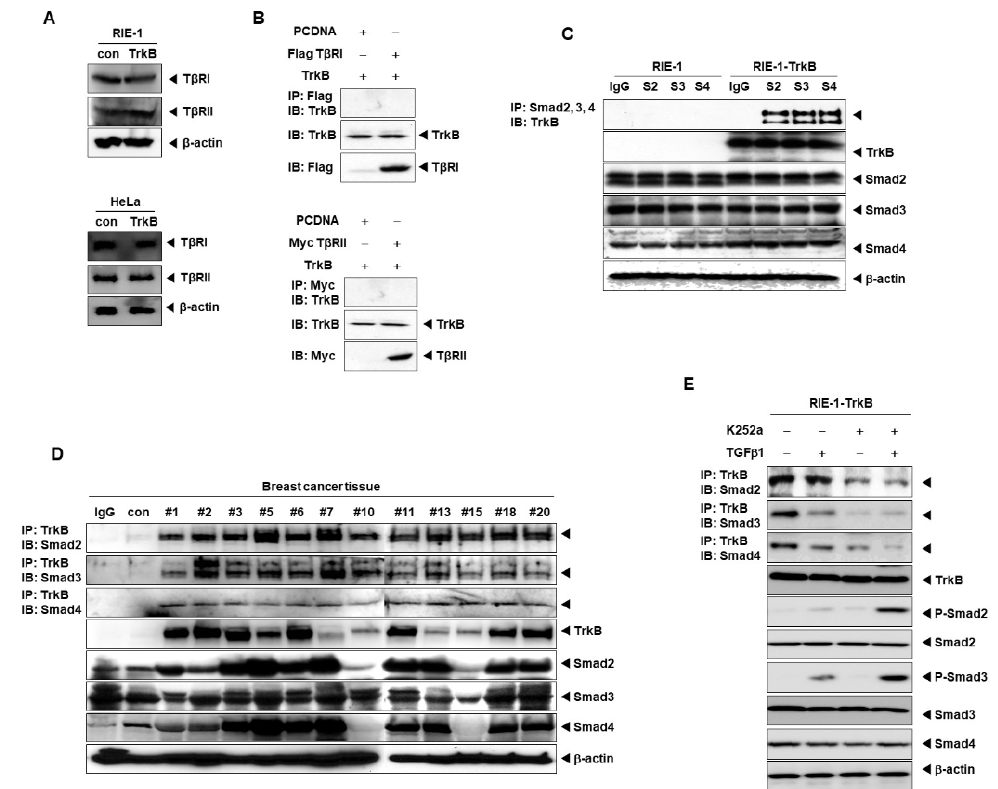
Figure 3. TrkB interacts with SMADs. ( A ) Western blot analyses of the expression of T β RI and T β RII in RIE-1, HeLa, RIE-1-TrkB, and HeLa-TrkB cells. ( B ) Western blot analyses of TrkB following immunoprecipitation of T β RI or T β RII from a whole-cell extract of transfected 293T cells. ( C ) Western blot analyses of TrkB following immunoprecipitation of T β RI or T β RII from a whole-cell extract of RIE-1 and RIE-1-TrkB cells. ( D ) Western blot analyses of TrkB following immunoprecipitation of SMAD2/SMAD3/SMAD4 from a whole-cell extract of tissues of breast cancer patients. ( E ) Western blot analyses of TrkB following immunoprecipitation of SMAD2/SMAD3/SMAD4 from a whole-cell